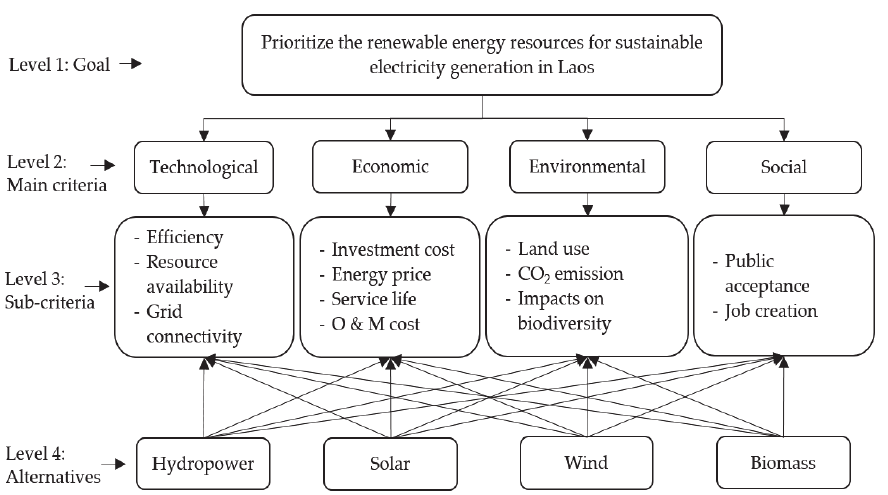
Figure 2. The structure of the AHP, adapted from